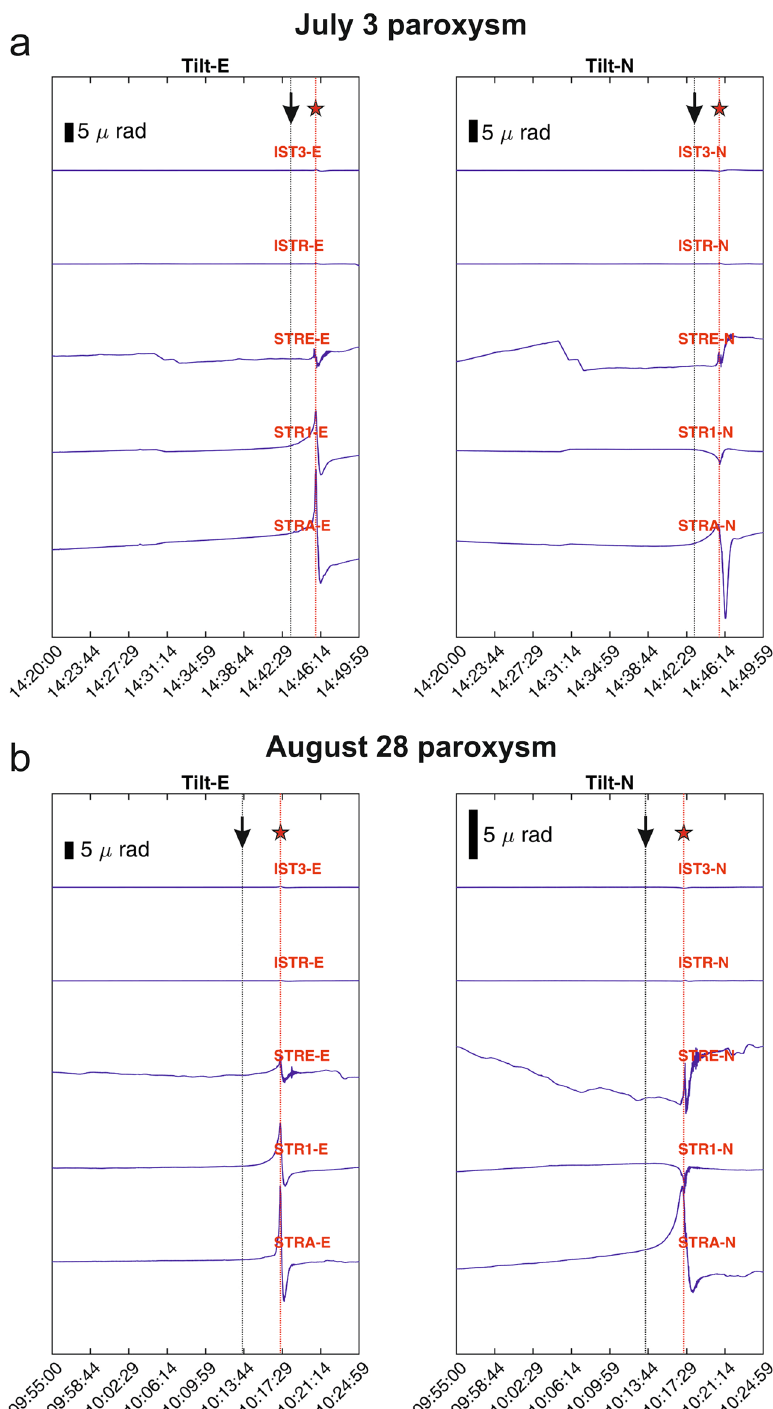
Figure 5. Tilt signals accompanying the July 3 and August 28, 2019 paroxysms. The red stars indicate the time of the paroxysms, and the arrows indicate the onset times of the inflation as detected by STA/LTA